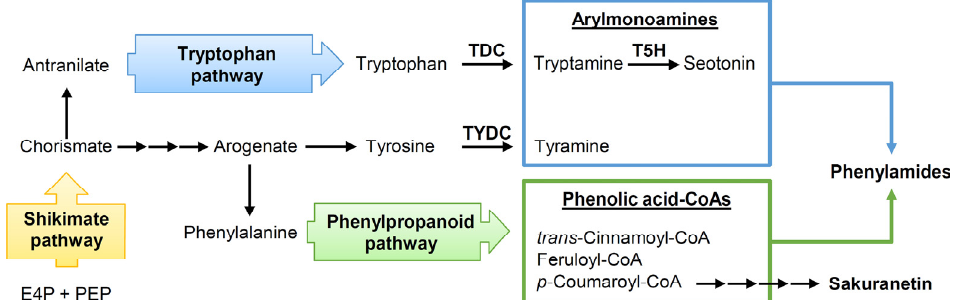
Figure 12. Biosynthesis of phenylamides and sakuranetin. Multiple arrows indicate multiple enzy- matic steps. E4P: erythrose 4-phosphate; PEP: phosphoenol pyruvate; T5H: tryptamine 5-hydroxylase (EC 1.14.-.-); TDC: L-tryptophan decarboxylase (aromatic-L-amino-acid decarboxylase, EC 4.1.1.28); TYDC: L-tyrosine decarboxylase (EC 4.1.1.25) (adapted from [21]).